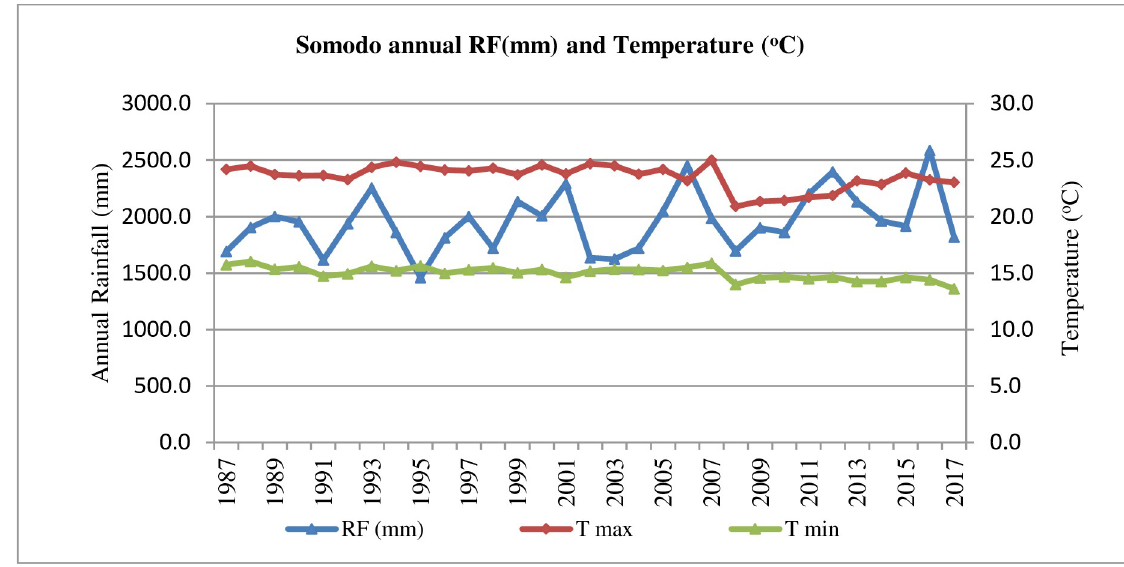
Fig 2. Mean of annual rain fall (mm) and temperature (˚C) of Sodomo